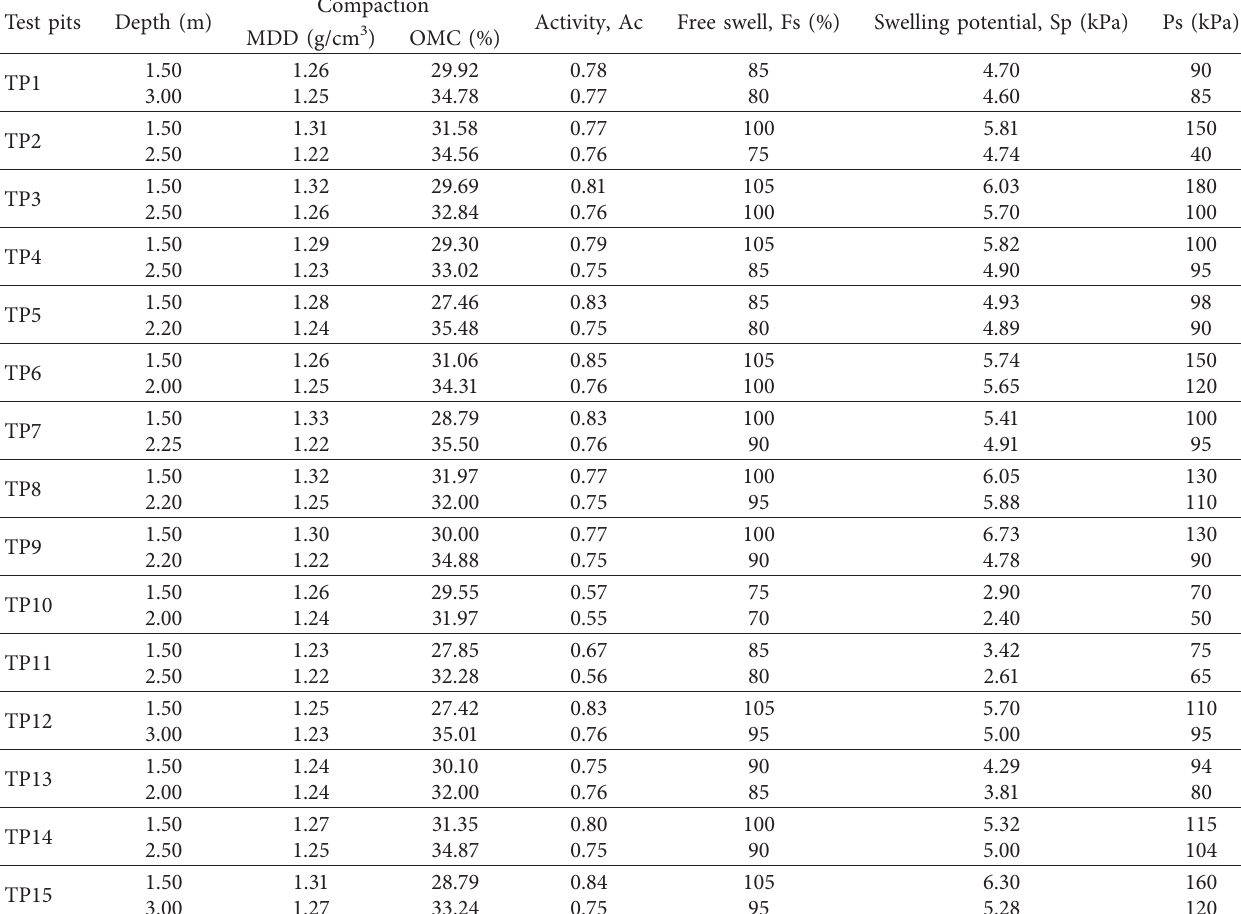
Table 3: Compaction properties and activity and swelling characteristics test